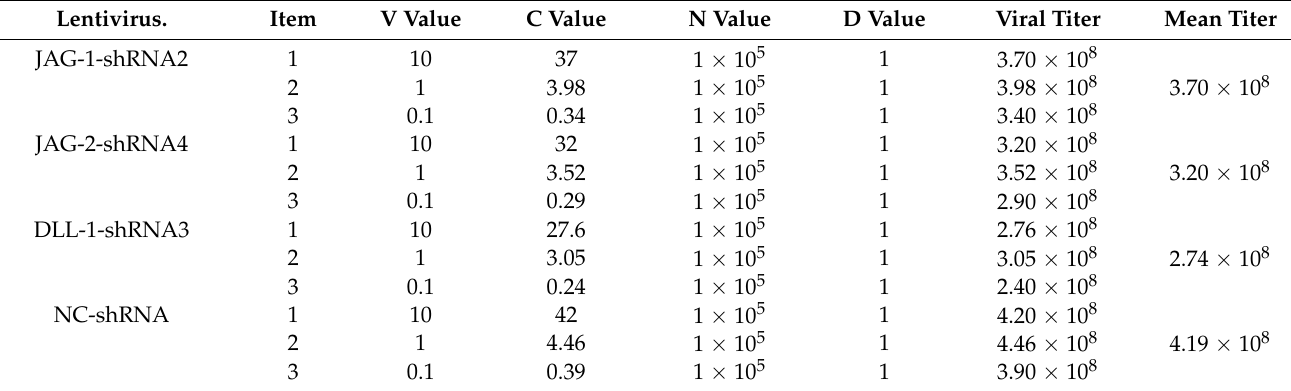
Table 1. Analysis of lentivirus titers by quantitative PCR.